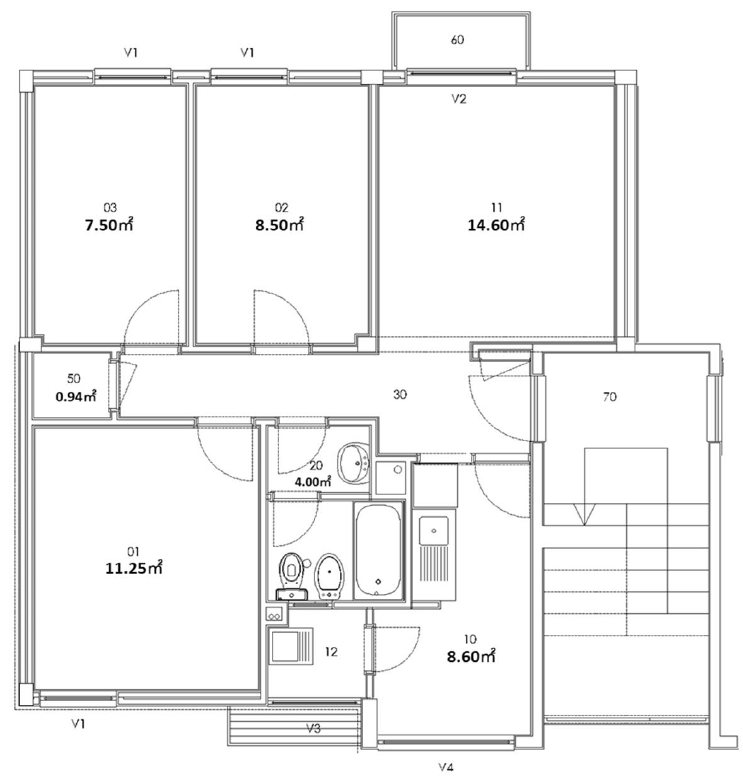
Figure 1. Sample apartment 2D drawing deliverable from the renovation